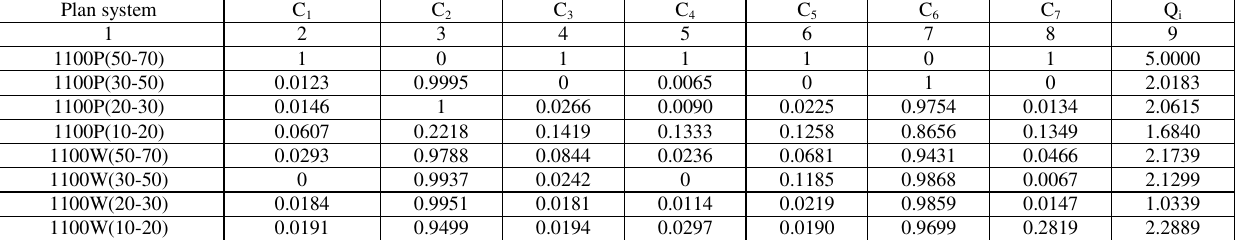
Table 7. Normalized values of diagnostic variables and value of the synthetic variable for NO